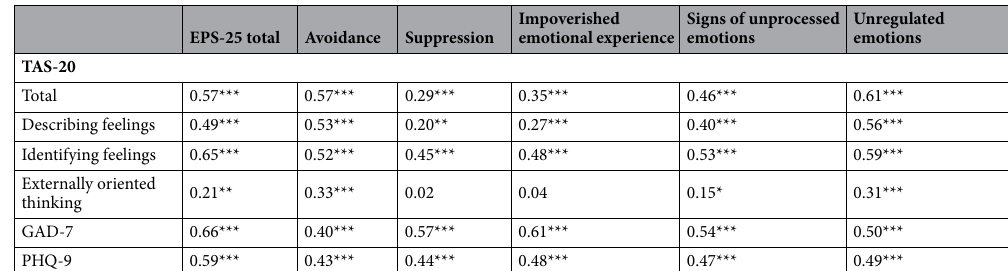
Signs of unprocessed